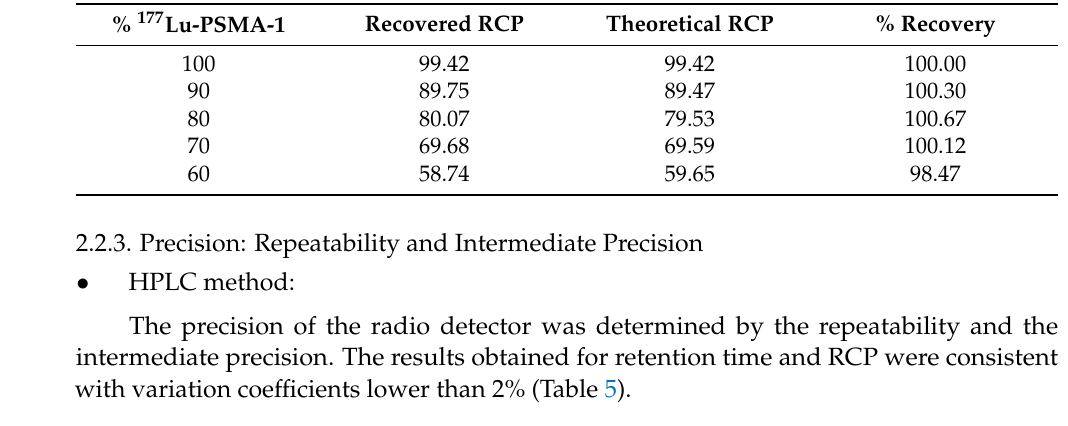
Table 5. Precision/repeatability and intermediate precision in